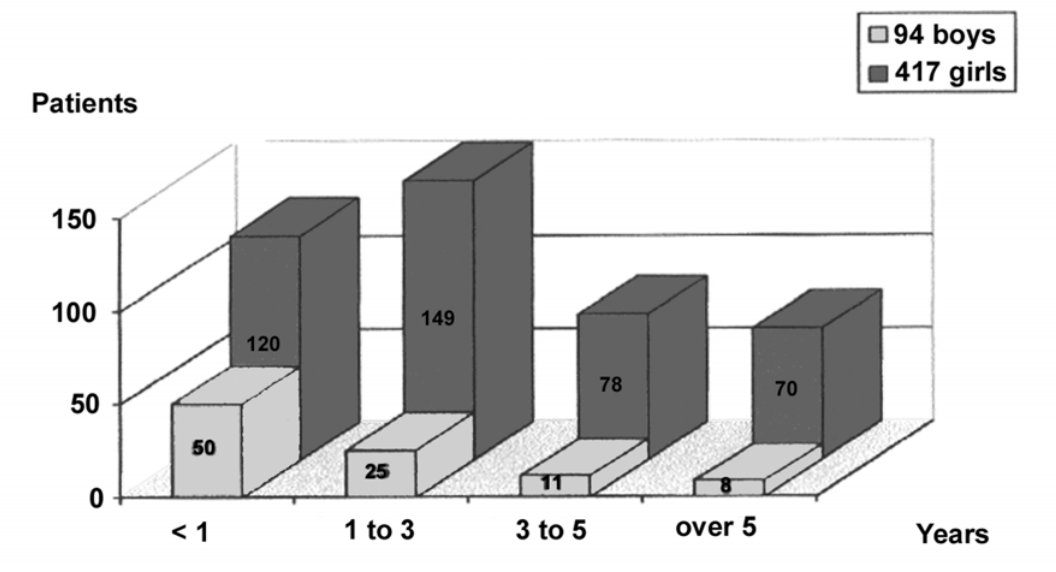
Figure 1 – Distribution of 511 children with vesicoureteral reflux undergoing treatment, divided according to gender and